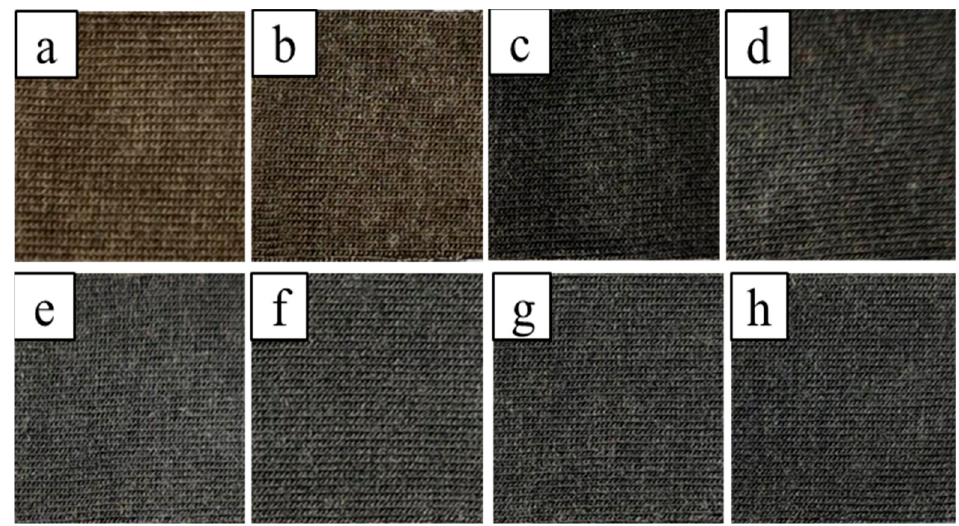
Figure 7. SEM images of samples at different reduction temperatures: 500× ( a ) 45 °C, ( b ) 55 °C, ( c ) 65 °C, ( d ) 70 °C, ( e ) 75 °C, ( f ) 80 °C, ( g ) 85 °C, ( h ) 90 °C. ( c ) 65 ◦ C, ( d ) 70 ◦ C, ( e ) 75 ◦ C, ( f ) 80 ◦ C, ( g ) 85 ◦ C, ( h ) 90 ◦ C.